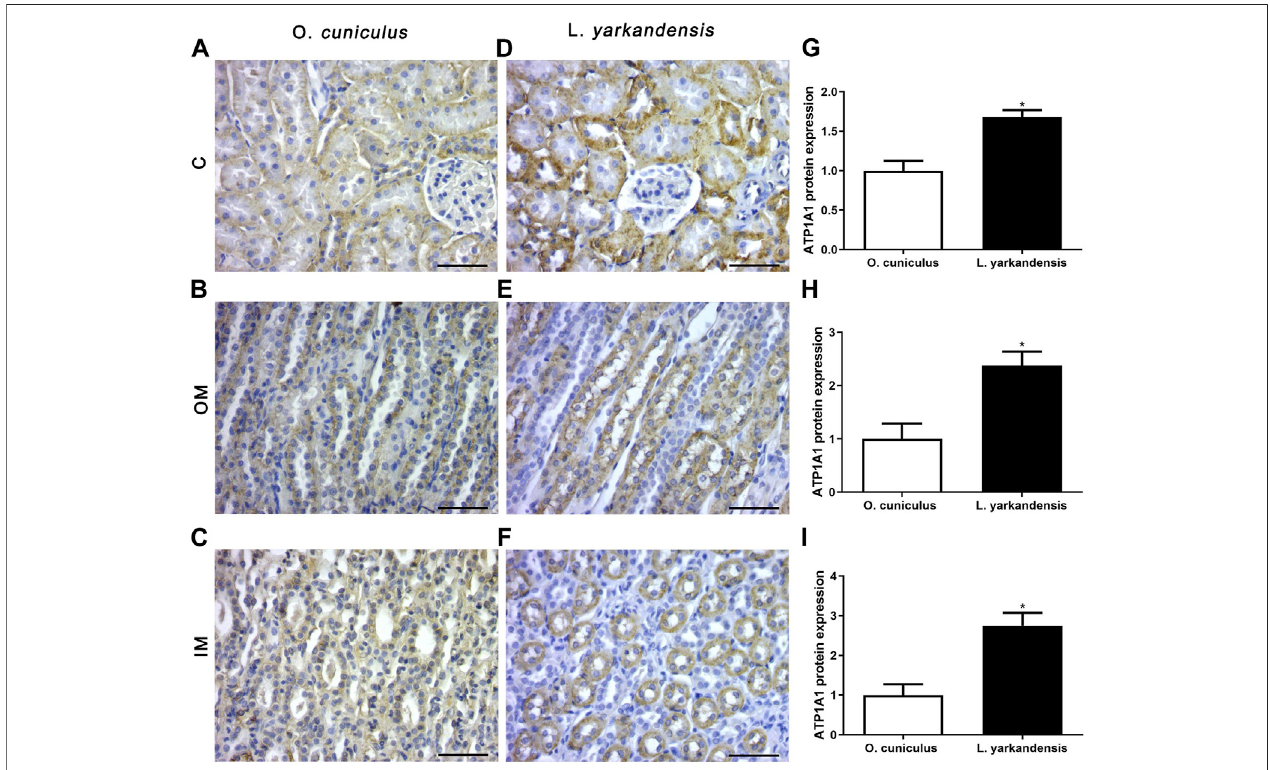
FIGURE 7 | ATP1A1 protein distribution in renal C, OM, IM in a tissue section of O. cuniculus and L. yarkandensis . Paraf fi n sections (6 µm) of renal cortex and medulla of O. cuniculus and L. yarkandensis (A-F) . The sections were incubated with an anti- ATP1A1 antibody scale bar 50 µm. Densitometry of all immunohistochemistry results of renal C and OM and IM from O. cuniculus and L. yarkandensis (n = 6 for each group), p p < 0.05 (G-I) . Average density showed a signi fi cant higher expression of ATP1A1 protein abundance in C and OM and IM of L. yarkandensis compared to that of O. cuniculus (G-I) .